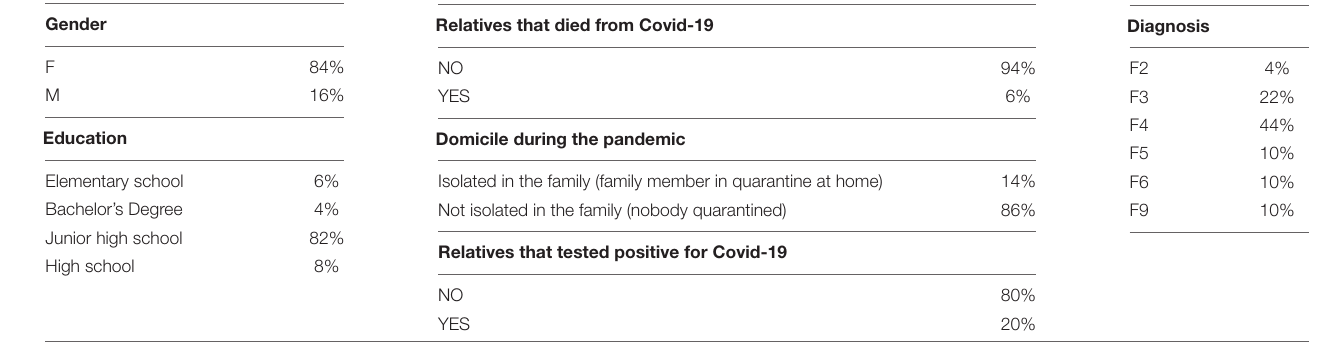
TABLE 1 | Demographic variables